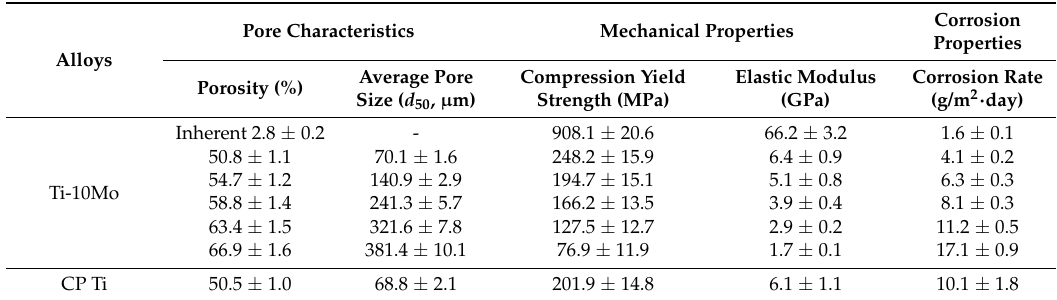
Table 4. Pore characteristics, mechanical and corrosion properties of different Ti base alloy samples.